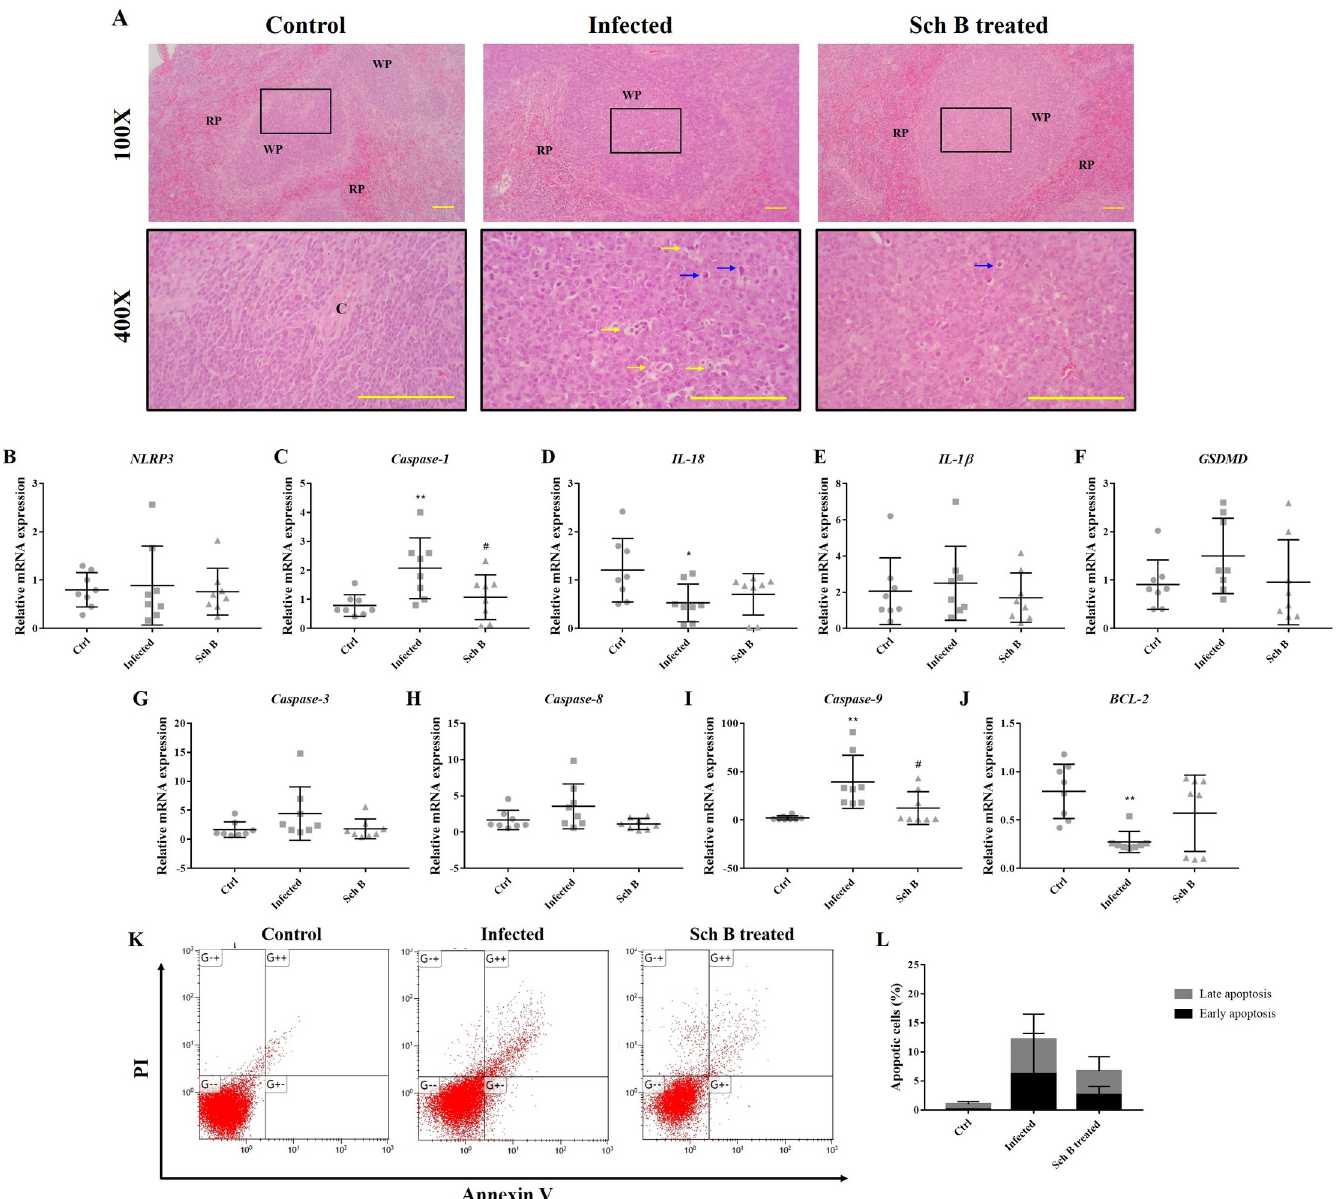
Fig 6. Sch B treatment resolves splenic inflammation and apoptosis in S . mansoni -infected mice. (A) Representative images showing H&E staining of spleen sections of the mice at 100 × and 400 × magnification. Tingible body macrophages (yellow arrows) containing apoptotic bodies (blue arrows) were seen in the splenic white pulp of S . mansoni -infected mice. Fewer apoptotic bodies were observed after S . mansoni -infected mice were treated with Sch B. Scale bars correspond to 200 μ m. RP, red pulps; WP, white pulps; C, central artery. (B-F) RNA transcription levels of inflammasome markers. (G-J) RNA transcription levels of apoptotic markers. Data are presented as mean ± S.D. (n = 8). (K) Representative plots showing Annexin V-FITC and PI double staining, measured by flow cytometry. (L) Percentages of apoptotic cells are shown as the mean ± S.D. (n = 5). � P -value < 0.05 and �� P -value < 0.01 compared with control group; # P -value < 0.05 compared with infected group.